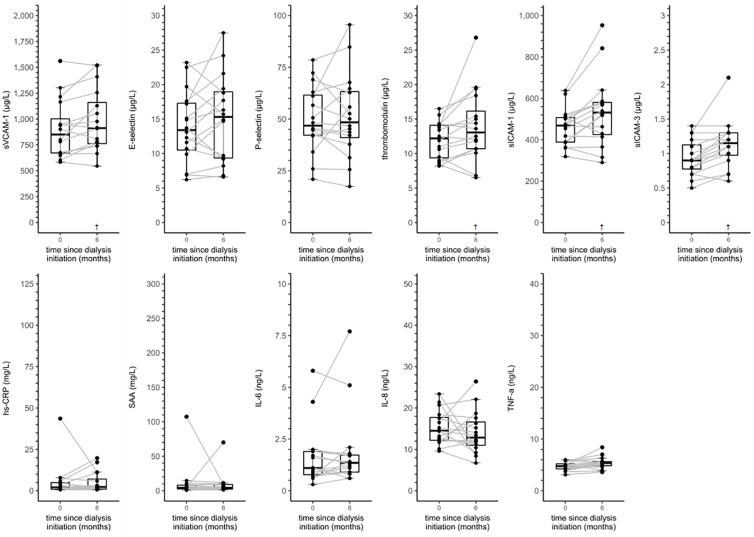
Boxplots and individual trajectories of serum biomarkers of endothelial dysfunction and low-grade inflammation over time in incident peritoneal dialysis patients.Abbreviations: hs-CRP, high-sensitivity C-reactive protein; IL-6, interleukin 6; IL-8, interleukin 8; NA, not applicable; SAA, serum amyloid A; sICAM-1, soluble intercellular adhesion molecule 1; sICAM-3, soluble intercellular adhesion molecule 3; sVCAM-1, soluble vascular cell adhesion molecule 1; TNF-α, tumor necrosis factor alpha. †
P value < 0.05 vs. baseline based on linear mixed model analyses with a random intercept.